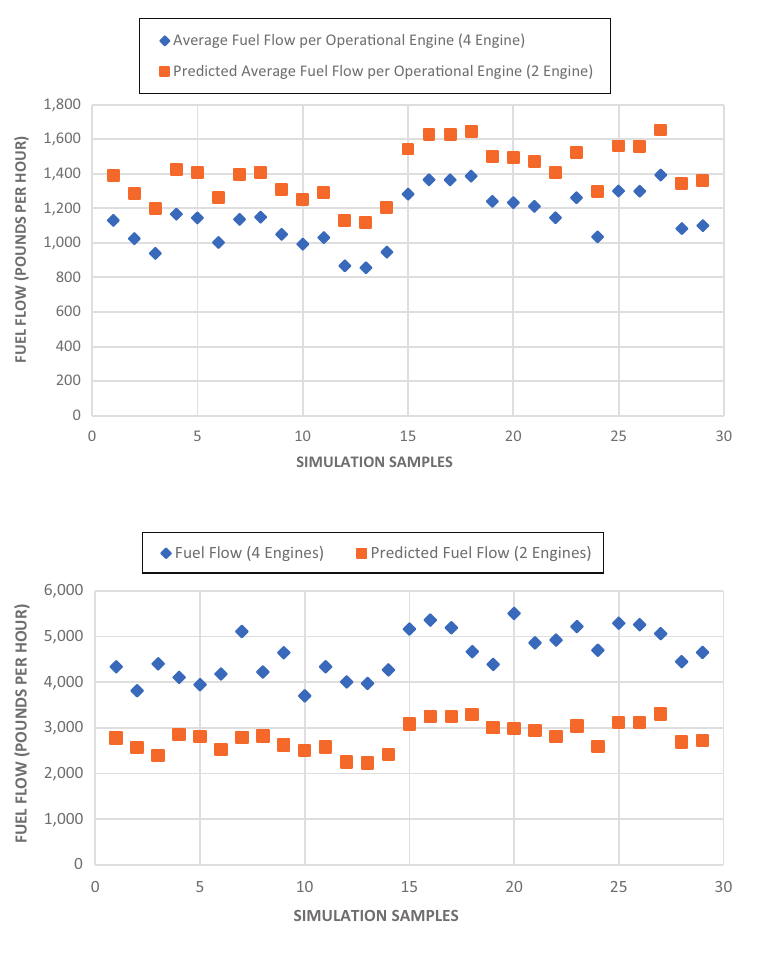
Figure 1. Four-engine and two- engine (predicted) fuel fl ow per operational engine comparison